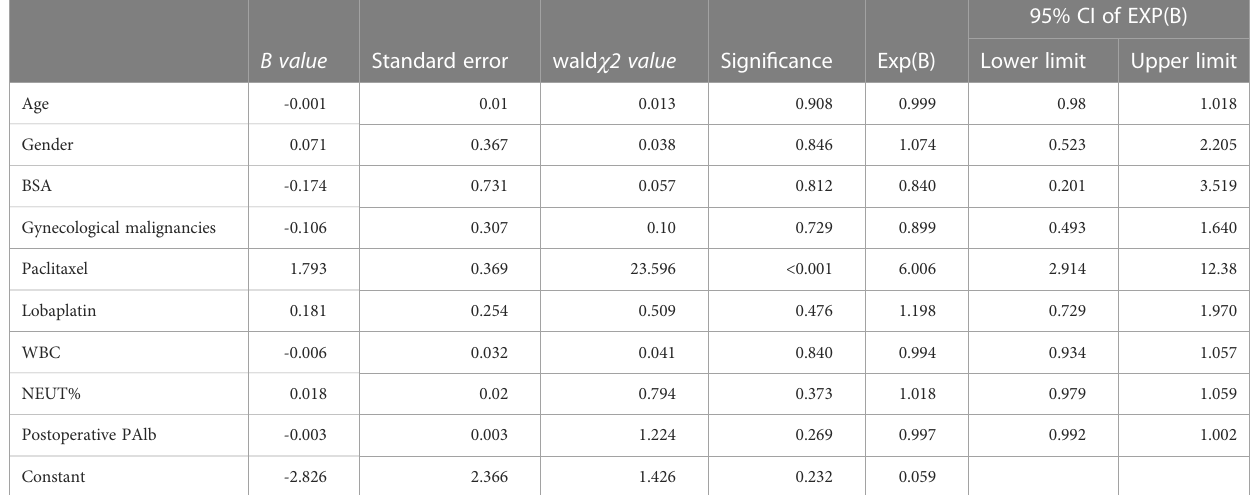
TABLE 3 Logistic regression analysis of CRS-HIPEC patients with temperature